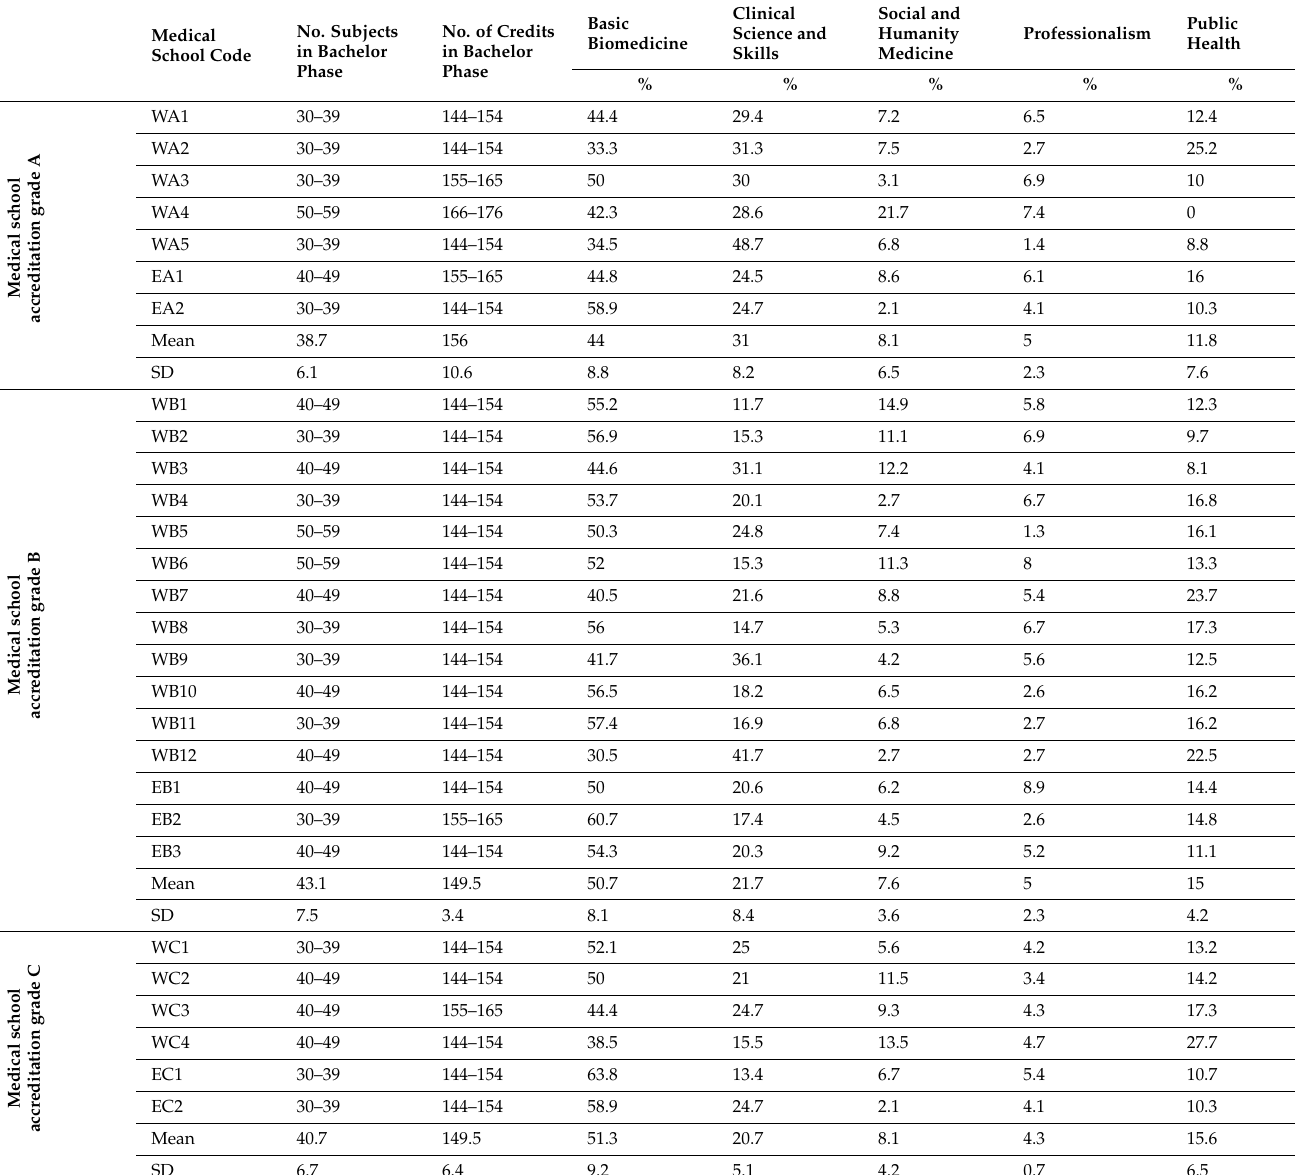
Table 1. Distribution of accreditation grade, educational group, and subject size of included medical schools in Indonesia. Medical School